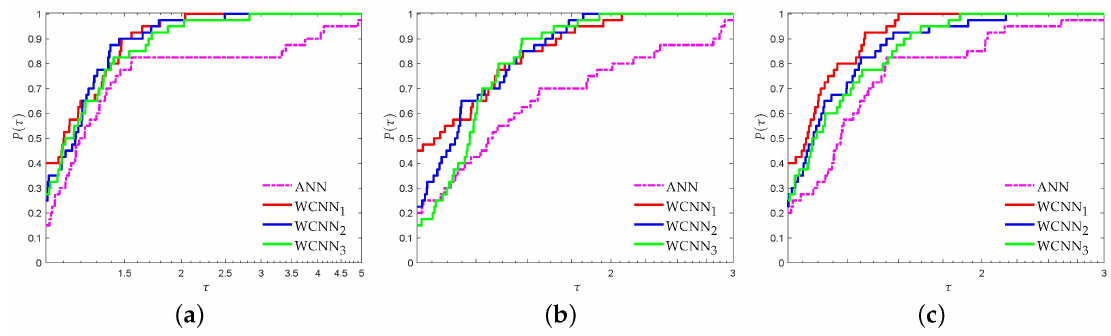
Figure 5. Performance profiles based on MAE for domestic tourists arrivals (log 10 scaled). ( a ) Forecasting horizon = 6; ( b ) Forecasting horizon = 9; ( c ) Forecasting horizon =